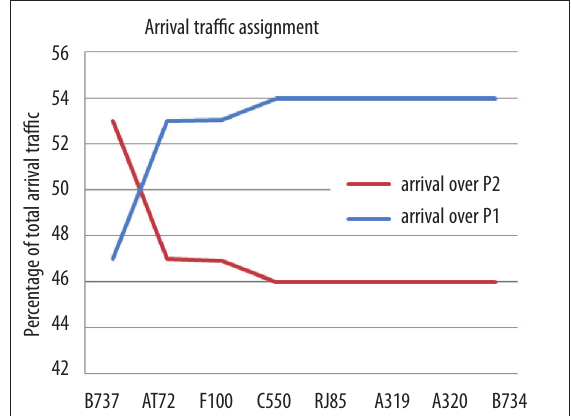
Fig. 13. Arrival traffic distribution for balanced pollution